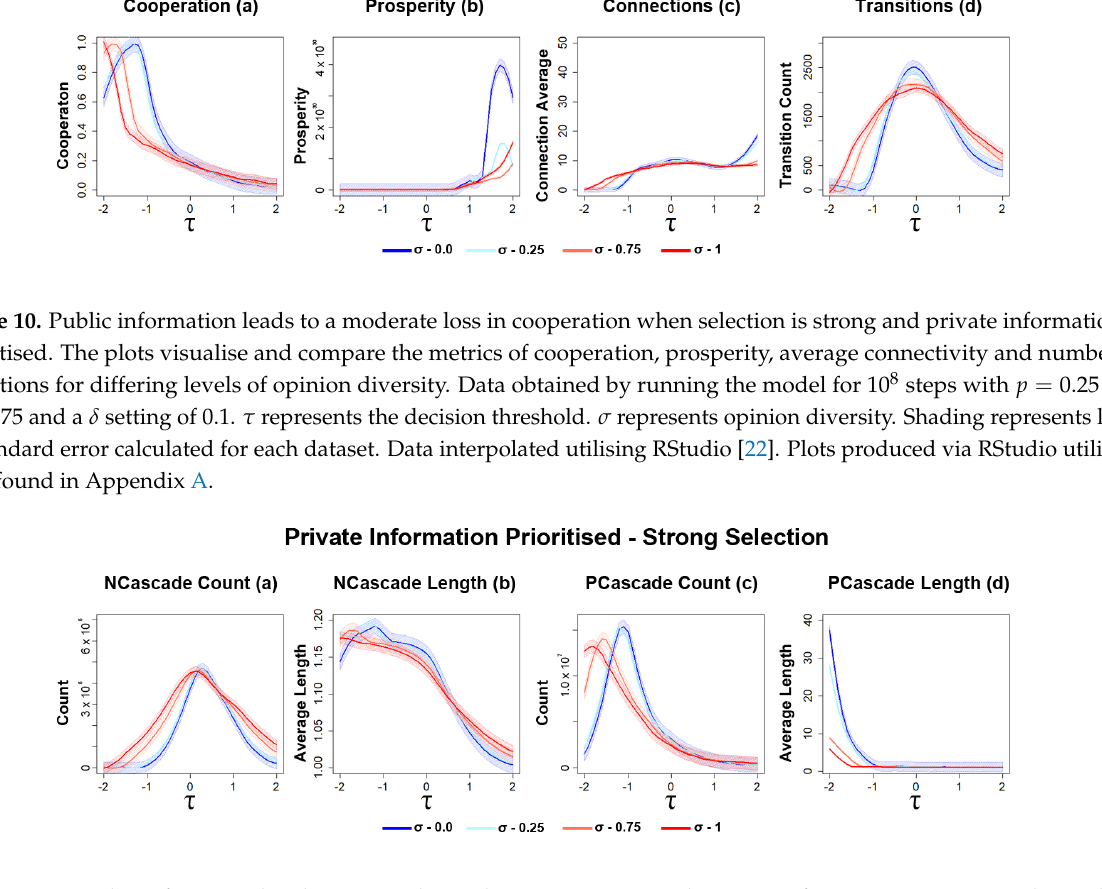
Figure 11. Number of P cascades decreases when selection is strong and private information is prioritised. For both cascade types, each graph represents either the number or average length of each cascade type. Under these circumstances, the number of P cascades that occurred gradually decreased as the level of diversity is increased, although there is some increase in areas for N cascades. Data obtained by running the model for 10 8 steps with p = 0.25 and q = 0.75 and a δ setting of 0.1. τ represents the decision threshold. σ represents opinion diversity. Shading represents level of standard error calculated for each dataset. Data interpolated utilising RStudio [22]. Plots produced via